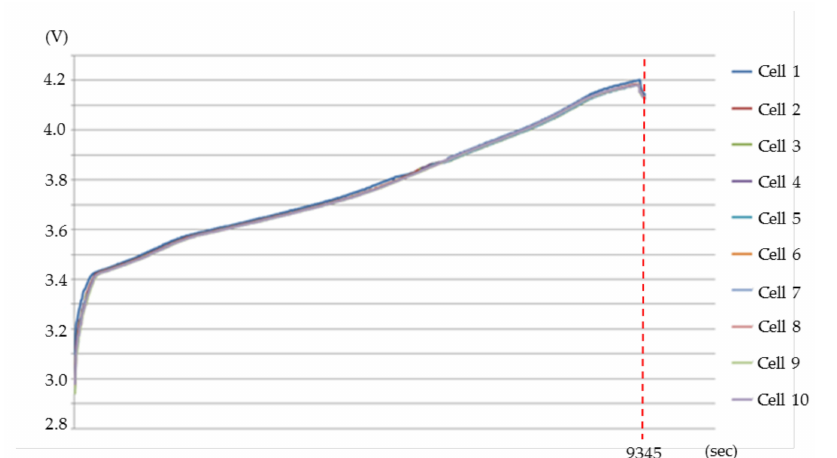
Figure 6. Charging curve measured by LTC6803.